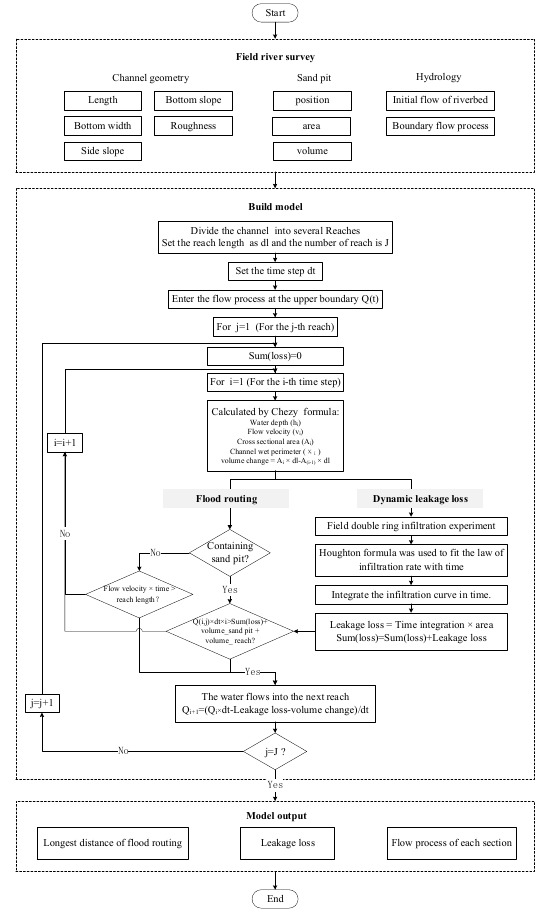
Figure 1. Model framework.